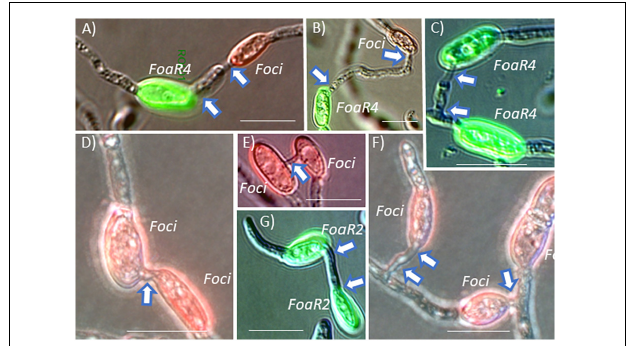
FIGURE 5 | F. oxysporum microconidia were pre-stained with a fluorescent dye conjugate and then mixed with a differently labeled strain. After incubation on polystyrene in conditions conducive for conidial anastomosis tube (CAT) formation, “homo” and “hetero” CAT formation was enumerated (as shown in the original publication). (A,B) F. oxysporum f. sp. apii race 4 ( Foa R4) and F. oxysporum f. sp. coriandrii 3-2 ( Foci ) formed hetero-CATs as frequently as each strain formed homo-CATs (C,D) . (E) In compatible interactions, CATs were most commonly formed between two microconidia, but occasionally, CAT clusters with three microconidia (F) were observed. F. oxysporum f. sp. apii race 2 ( Foa R2) also formed homo-CATs (G) but Foa R2 and Foa R4 were never observed to form a hetero-CAT. Short CATs are indicated with a single arrow and longer CATs are indicated with an arrow at each end of the CAT. Size bars = 10 µ m. The image is a portion of a figure from Henry et al. (2020). (BMC Genomics 21, No. 730) and is reprinted in accordance with BMC